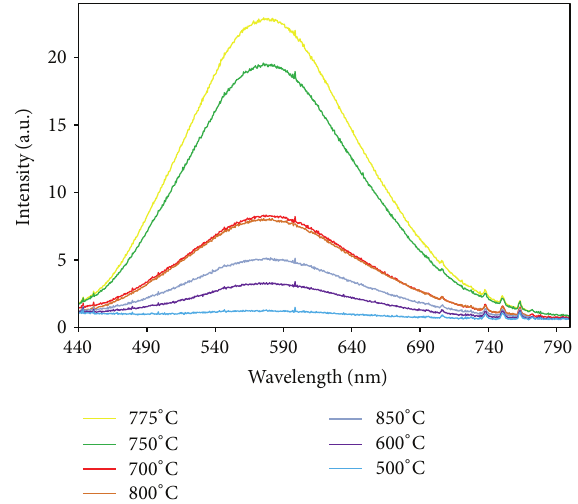
Figure 5: Effects of synthesis temperature on the PL emission intensity of Zn 3 V 2 O 8